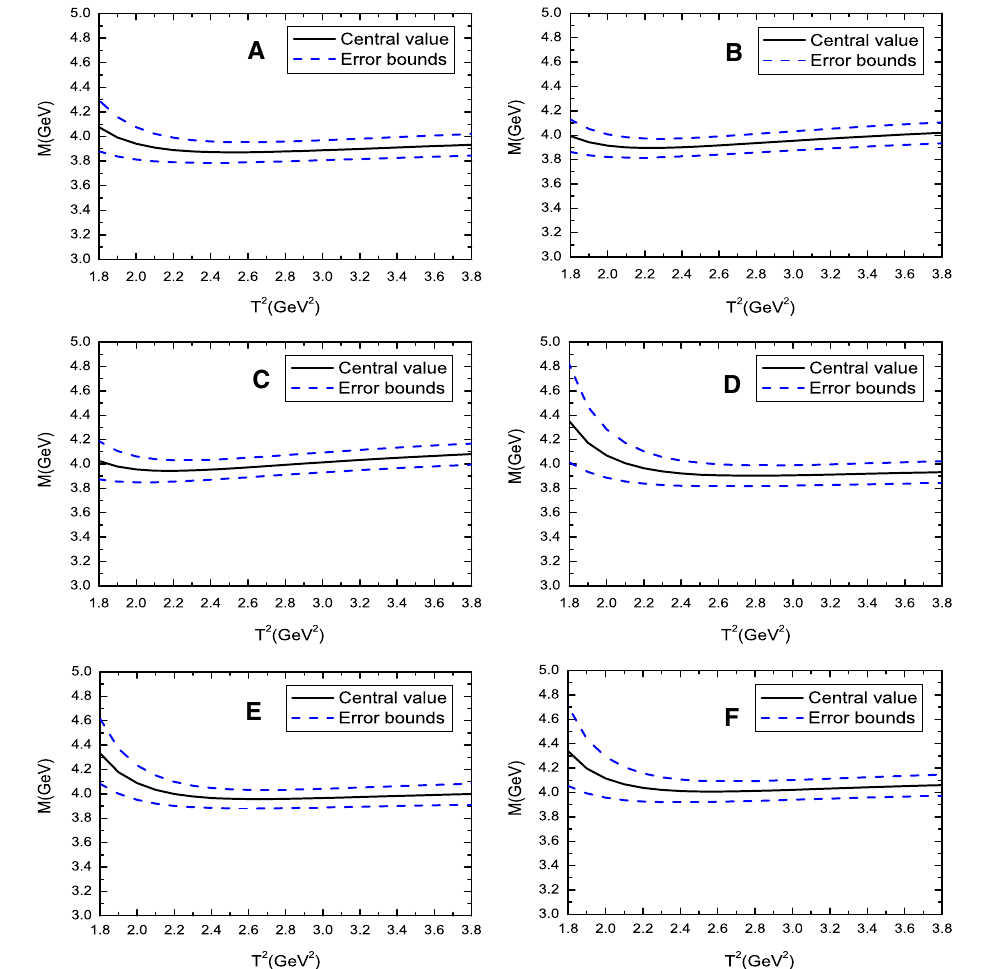
Fig. 2 The masses with variations of the Borel parameters, where a – f denote the tetraquark states cc ¯ u ¯ d ( 0 + ) , cc ¯ u ¯ s ( 0 + ) , cc ¯ s ¯ s ( 0 + ) , cc ¯ u ¯ d ( 1 + ) , cc ¯ u ¯ s ( 1 + ) and cc ¯ s ¯ s ( 1 + ) ,